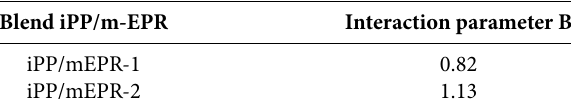
Table 3 . Interaction parameter B for iPP/m-EPR blends